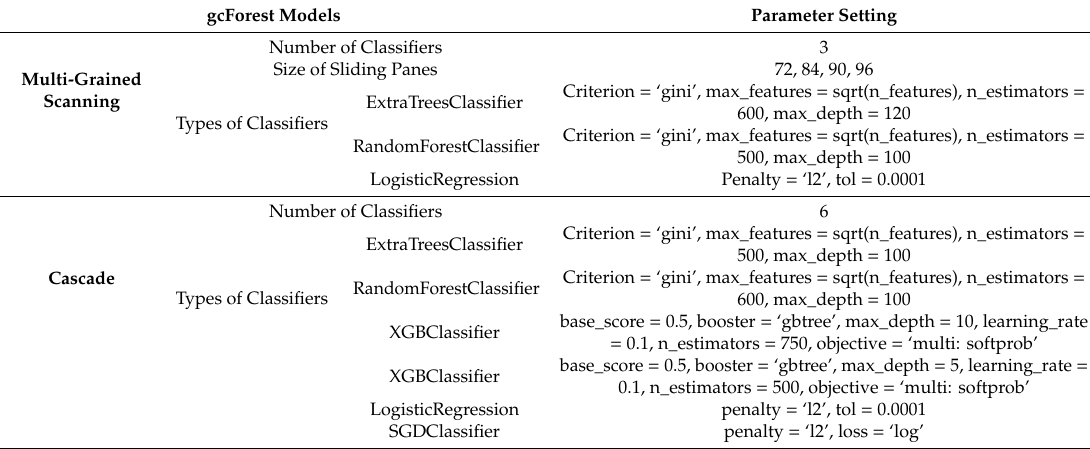
Table 16. Optimized experimental parameter setting.